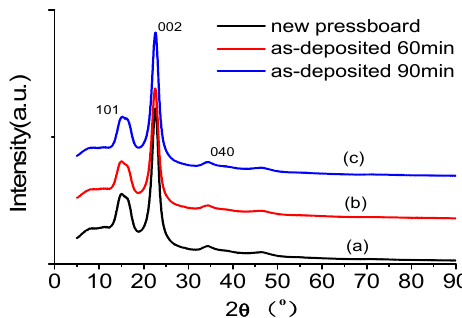
Figure 7. X-ray diffraction (XRD) of the fresh pressboard ( a ); pressboard surface fabricated Al 2 O 3 film 60 min ( b ) and 90 min ( c ).